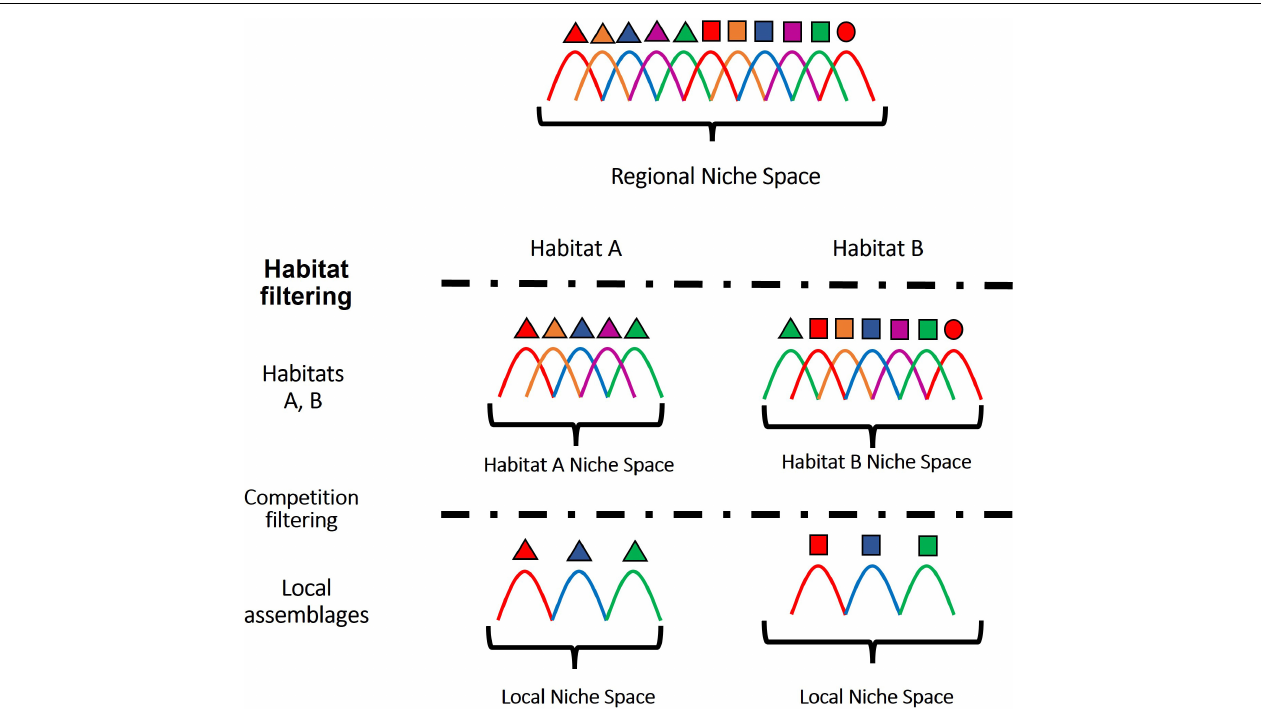
FIGURE 1 | Habitat and competition filters simultaneously shape the niche space of local assemblages. Species are represented with different shapes and colors. Each species niche width and abundance is represented with a distribution curve positioned along an ecological gradient that represents the regional niche space. Within each habitat, only a narrower set of species is able to survive in relation to their traits. In local assemblages, competition may result in the local extinction of similar competitors, due to the limiting similarity principle, selecting for an overdispersed niche space compared to the potential niche range within that